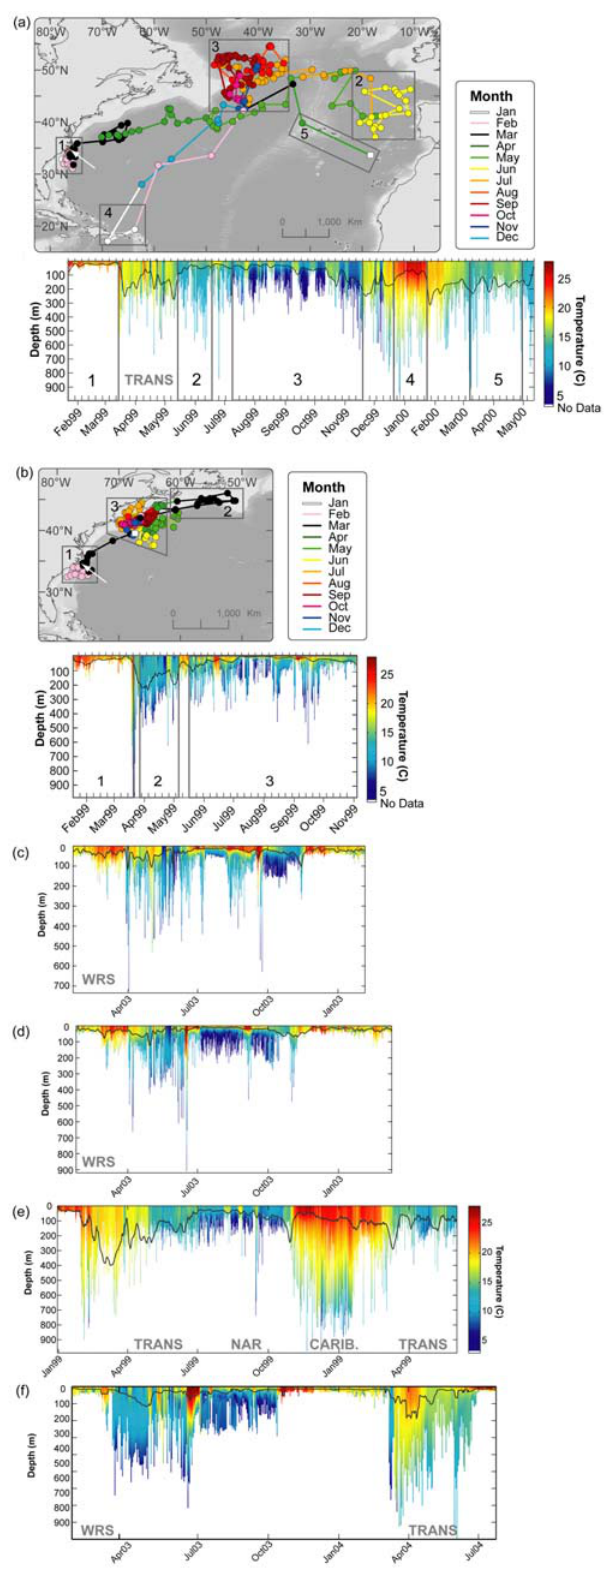
Figure 10. (a)–(b) Monthly geolocation estimates and track of individual Atlantic bluefin tuna with corresponding depth and temperature profiles indicating maximum diving behavior in relation to water temperature. Black boxes indicate